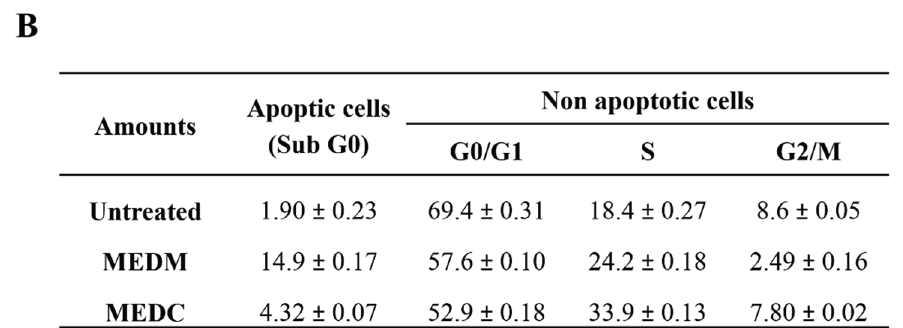
Figure 7. Cell cycle analysis of HeLa cells at 24 h. After treatment with MEDM and MEDC, cells were collected and stained with PI, and then flow cytometry analysis was performed. ( A ) Representation of the dot plots obtained from flow cytometry; ( B ) Table summarizes the mean of values obtained in three determinations ± standard